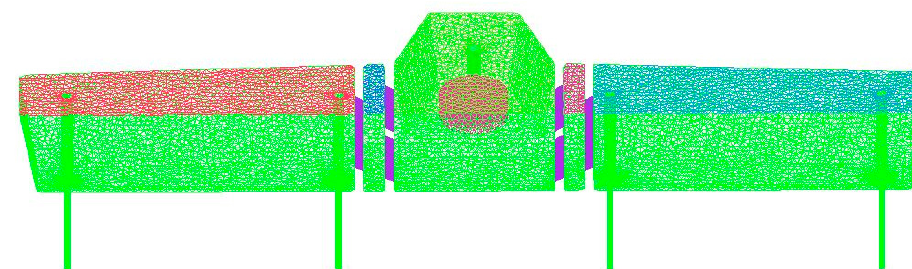
Figure 5. Unstructured meshing effect diagram.